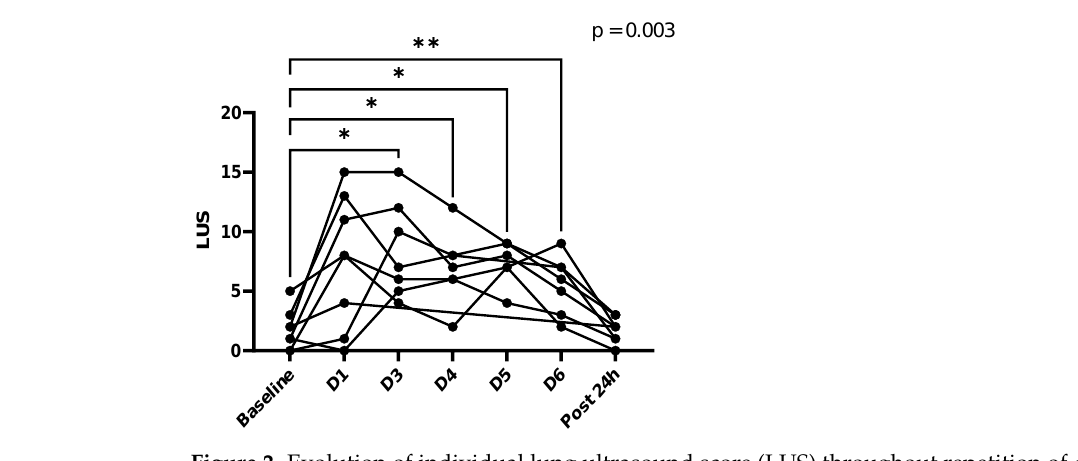
Figure 2. Evolution of individual lung ultrasound score (LUS) throughout repetition of day dives. All divers developed B-lines after several dive days and a return to baseline 24 h after the last one. p -value for the ANOVA. Tukey’s multiple comparisons test is expressed versus baseline with * p < 0.05, ** p < 0.01.